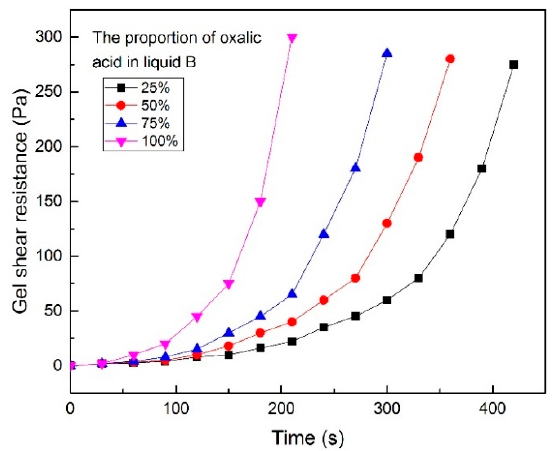
Figure 3. Curve of gel shear resistance versus time under different proportions of oxalic acid in liquid B.